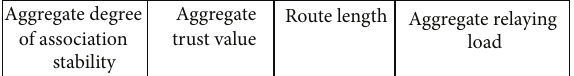
Figure 4: Format of QTABR-BQ reply control packet.